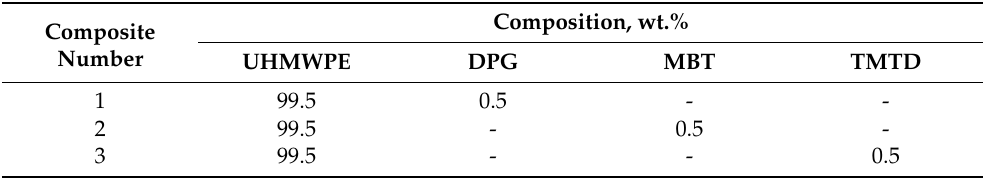
Table 2. The content of fillers in polymer composite materials based on